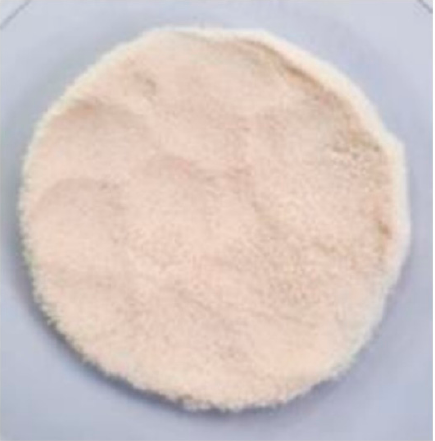
Figure 2. The isolated chitosan from vaname shrimp shell. Table 5. Chitosan characteristics are based on the pharmaceutical requirement.